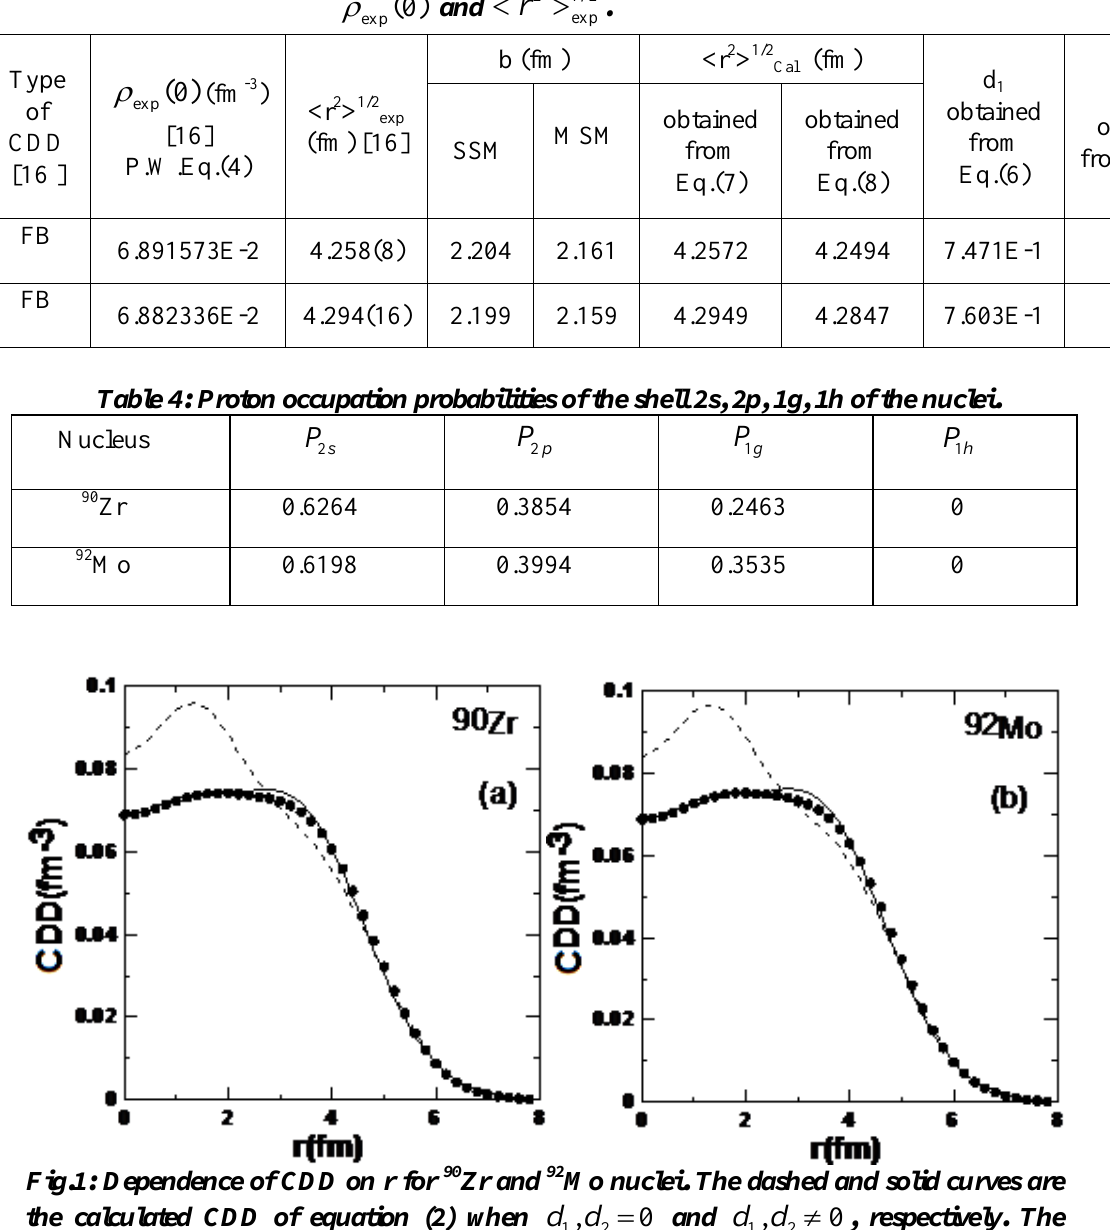
 dd and 0,  dd , respectively. The 21 21